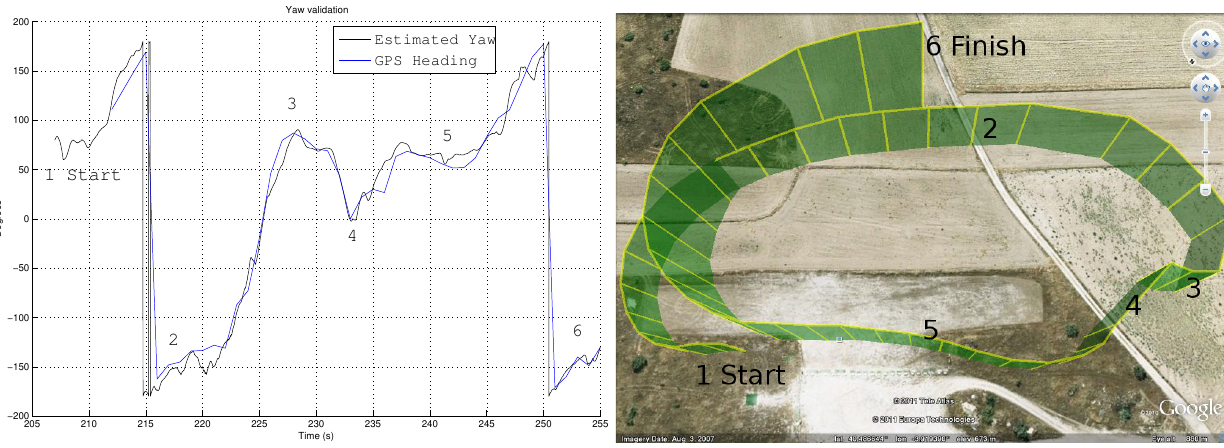
Figure 14. Yaw angle comparison between GPS system and UKF